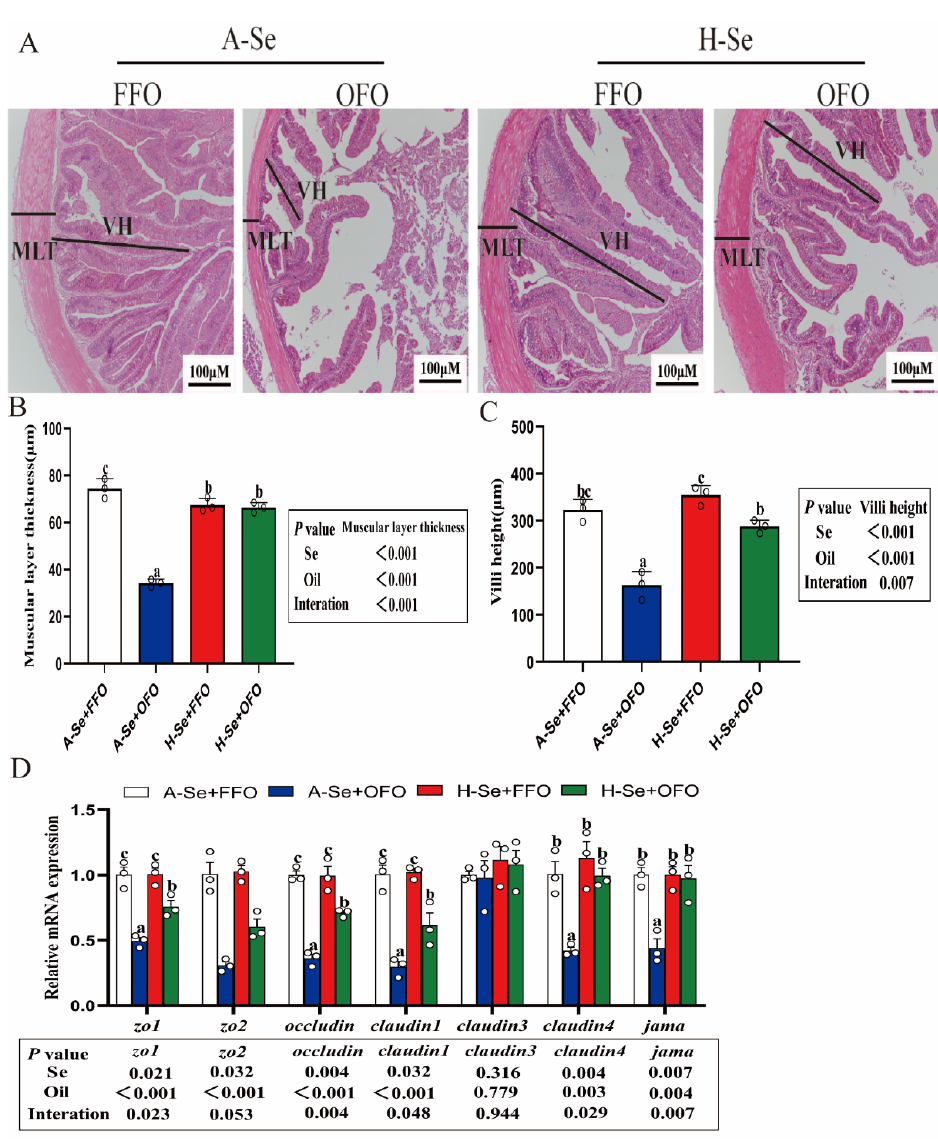
Figure 1. High levels of selenium alleviated the damage that was induced by oxidizing fish oils in the intestine of yellow catfish. ( A ) H and E staining. ( B ) Quantification of intestinal muscular layer thickness. ( C ) Quantification of intestinal villi length. ( D ) The mRNA levels of intestinal barrier. All data were mean ± SEM ( n = 3). “a–c” indicate meaningfulness at p < 0.05. p value was calculated by two-way ANOVA. MLT, muscular layer thickness; VH, villi